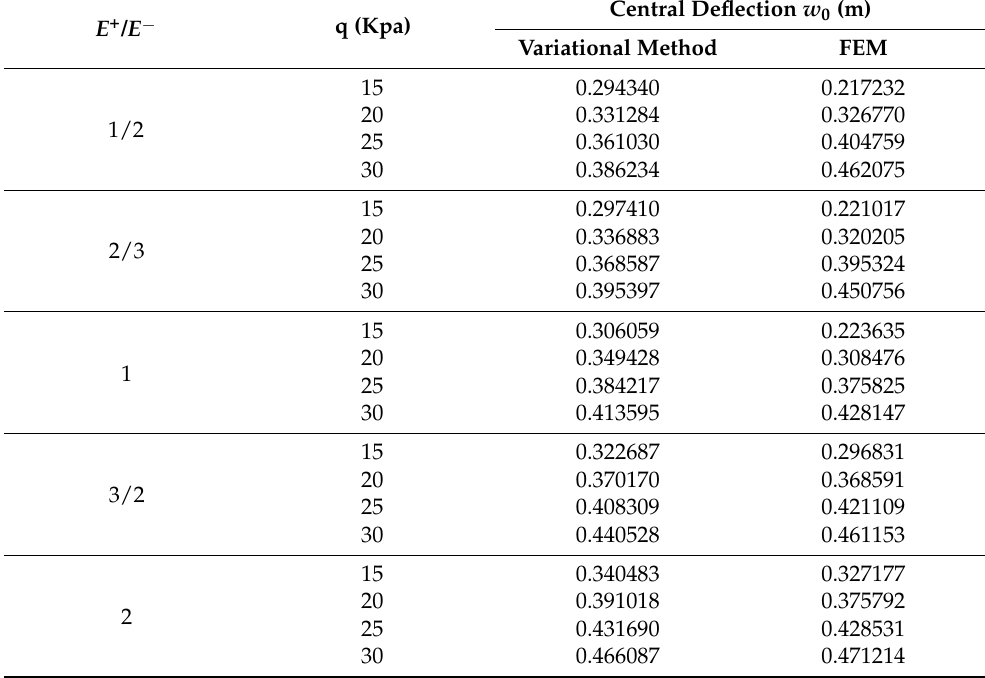
Table 2. Central deflections under different bimodular cases and loads ( Ra 2 / t = 1).